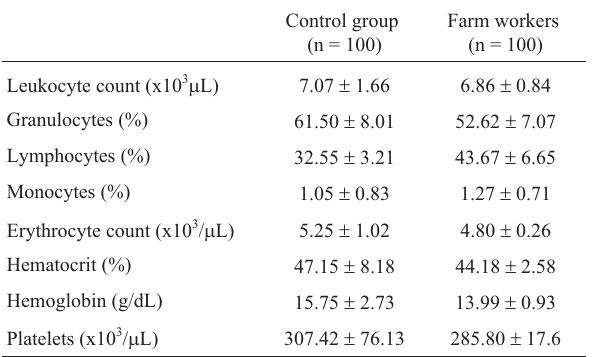
Table 3 - Hematological parameters in the study groups (mean + SD).